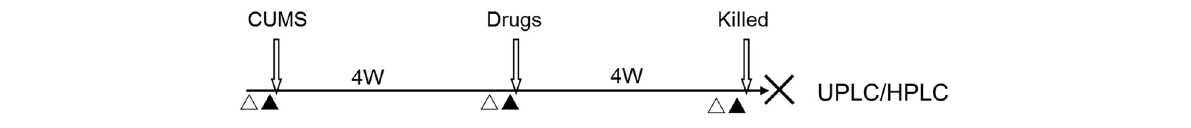
Fig. 1 Overall flow of the experimental design. △ : The assessment of depressive-like behaviors at different time points; ▲ : The detection of body weight at different time